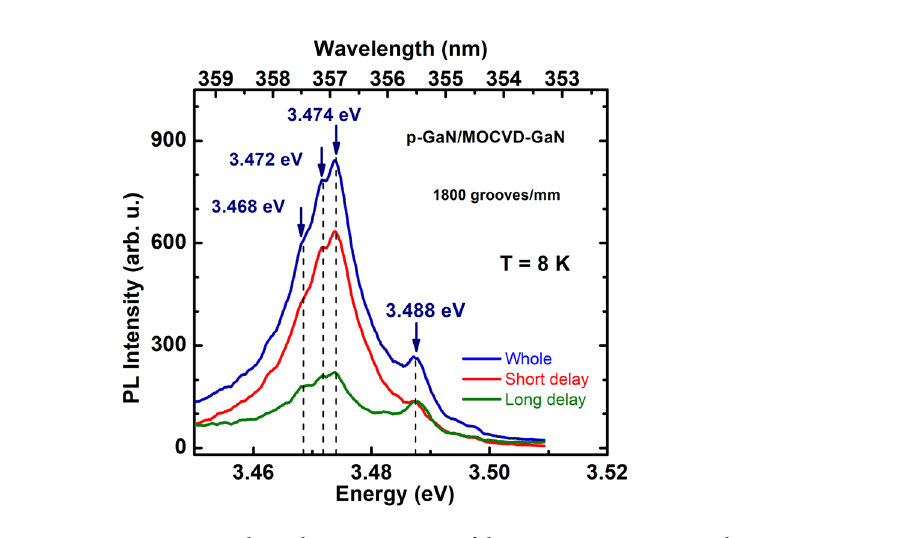
Figure 3. High resolution PL spectra of the porous GaN grown on the MOCVD-GaN template. Dashed lines are guides to the eyes. The 3.488-eV line originates from the MOCVD GaN